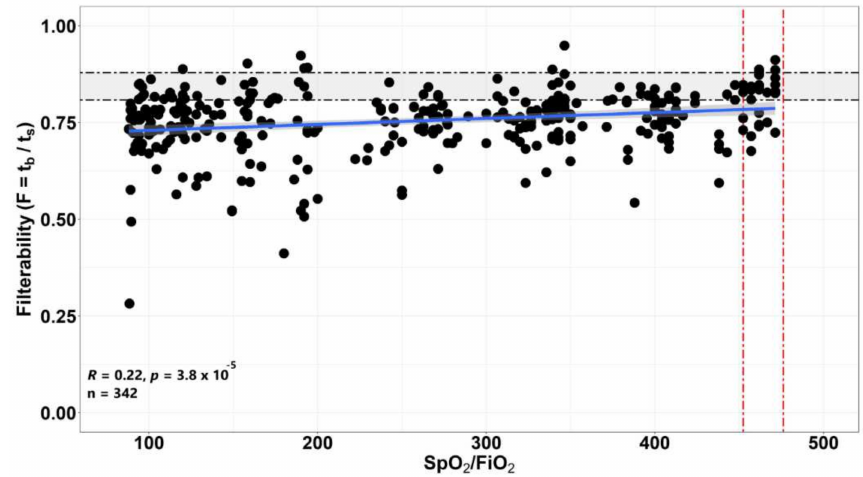
Figure 2. Correlation of RBC filterability in patients with COVID-19 with the value of the SpO 2 /FiO 2 ratio, where SpO 2 in each case is directly measured by a pulse oximeter, and FiO 2 for each point corresponds to the proportion of oxygen in the inhaled mixture (for atmospheric air FiO 2 = 0.21, the proportion of oxygen in the inhaled air at different oxygen flow rates was calculated by the standard method [27]). The gray area represents the confidence interval. Horizontal dotted lines show the boundaries of normal filterability